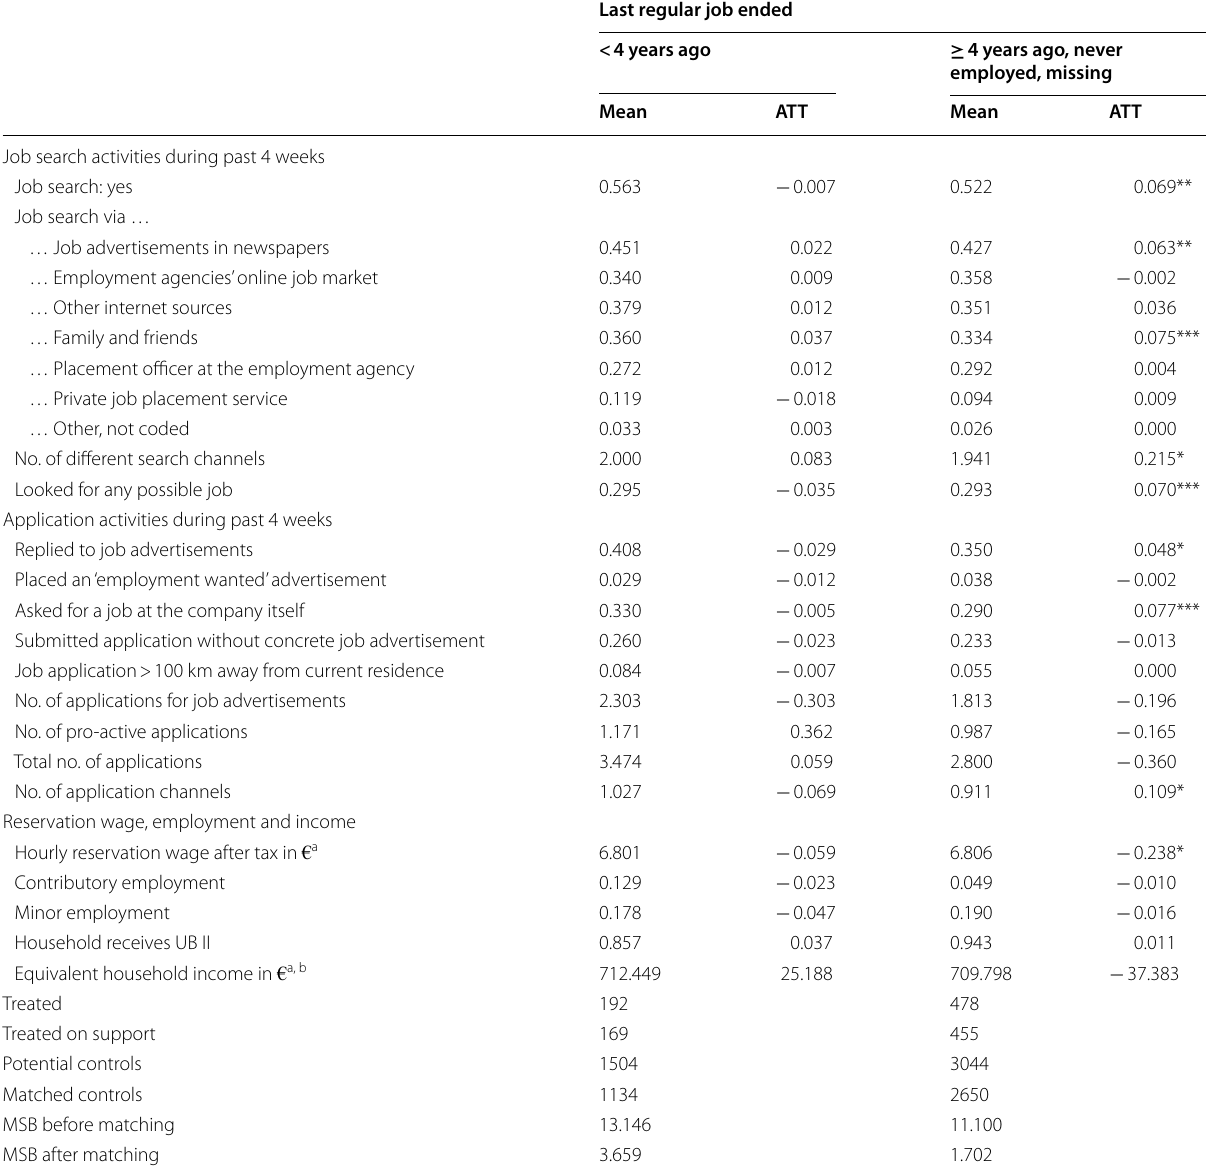
Table 6 ATT of receiving a One‑Euro‑Job announcement and mean outcomes for matched controls by time since